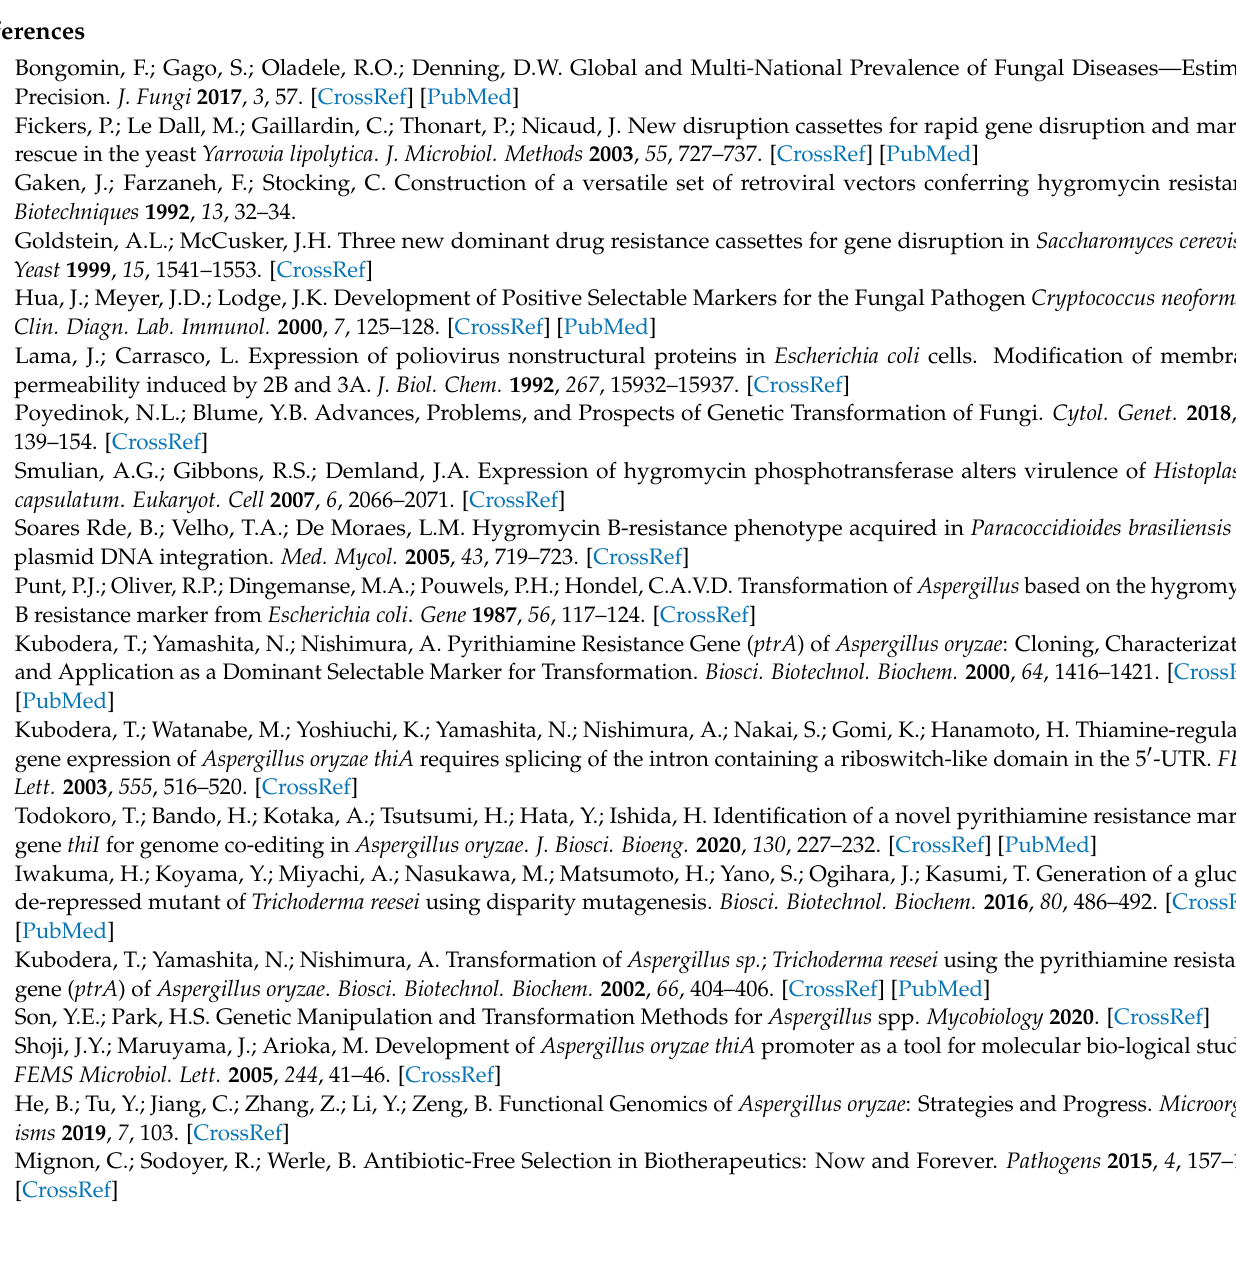
transformation constructs, Figure S2: Southern blot analysis of A. fumigatus transformants, Figure S3: Hygromycin susceptibility growth assay, Figure S4: Overview of A52 growth over the complete series of thiamine dilutions, Figure S5: Overview of A52 growth over the complete series of serial dilution of supernatants collected after 18 h cultures, Table S1: Primers used in this